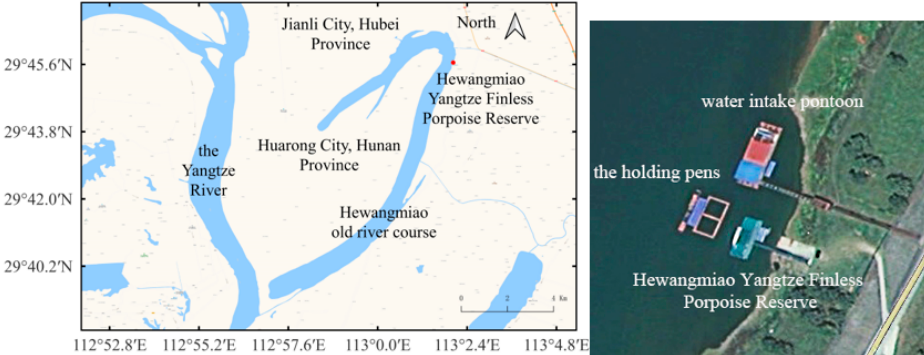
Figure 1. Study site: Hewangmiao Yangtze Finless Porpoise Reserve, China.